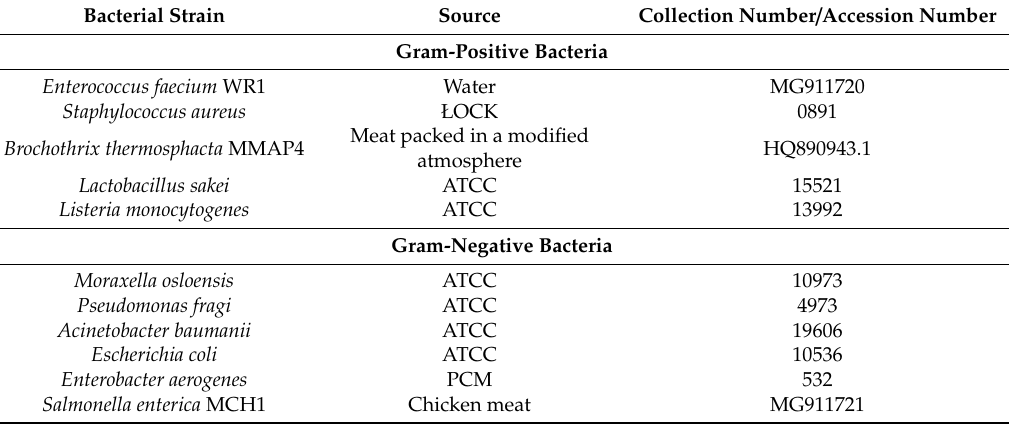
Table 5. Bacterial strains used in microbiological